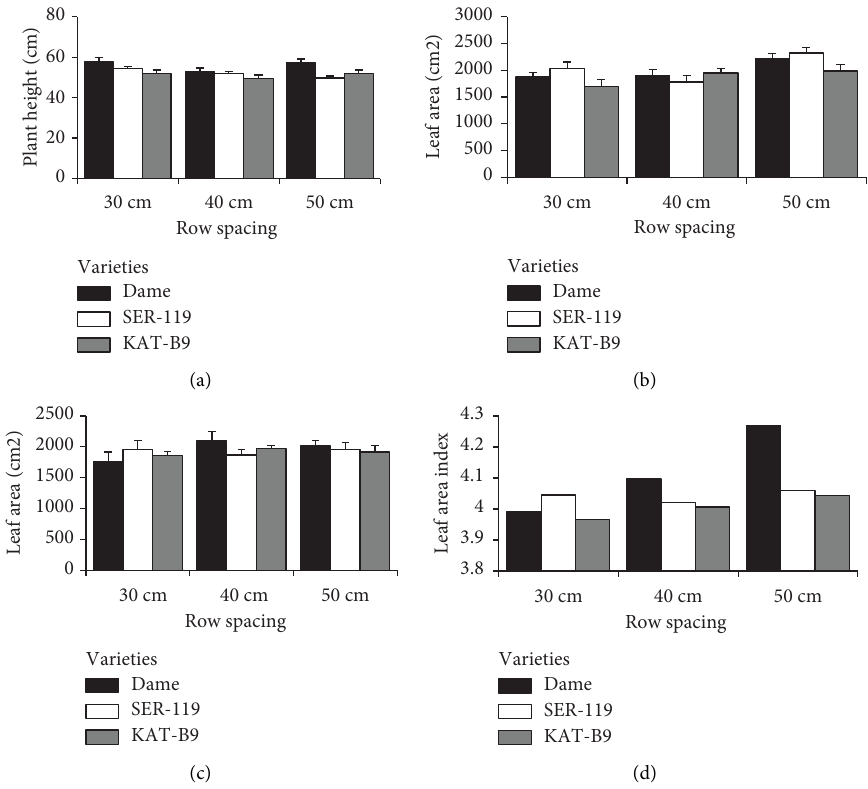
Figure 2: Interactive efect of interrow spacing × variety on (a) plant height at Arsi Negele; (b) leaf area at Arsi Negele; (c) leaf area at Melkasa; and (d) leaf area index at leaf area at